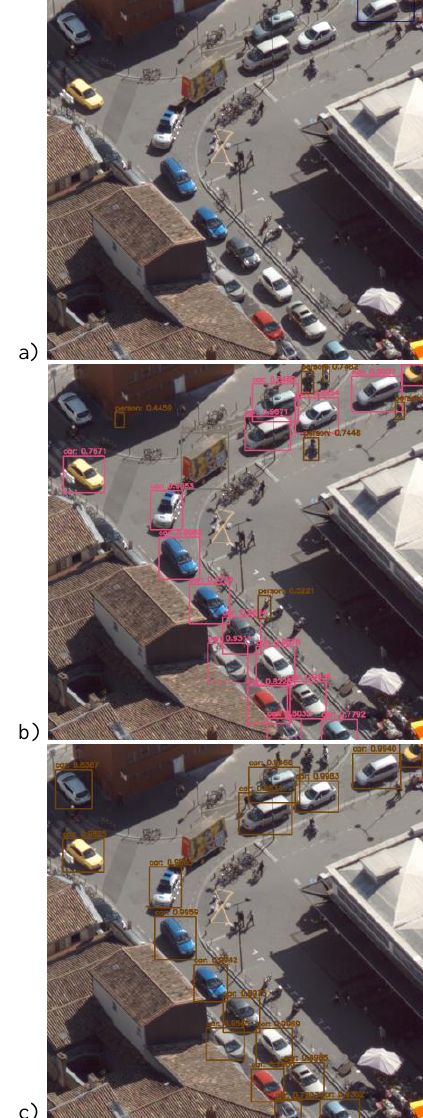
Figure 5. Detection results by YOLO network trained on three different datasets: a) DIOR, b) MSCOCO, c) a custom set consisting of detection results (annotations) on oblique images from the previous two steps (test area from